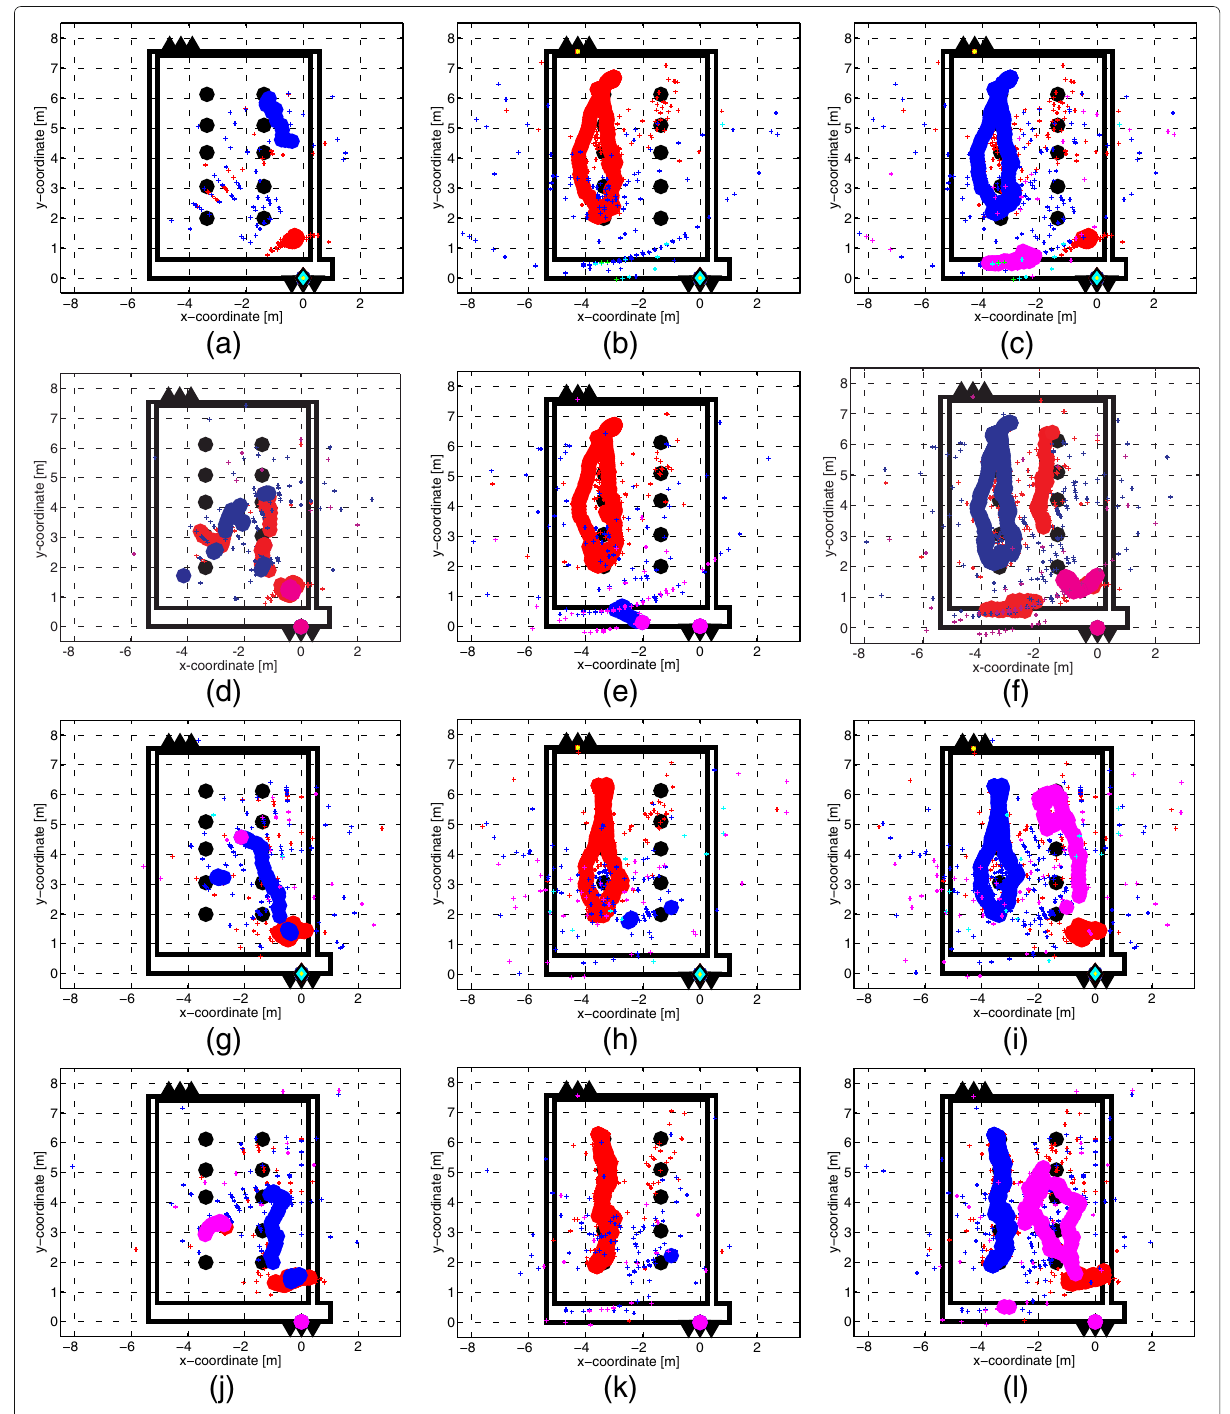
Fig. 12 Tracking results for scenario 2. Standard location of antennas and standard signal processing: a autonomously working sensor S1, b autonomously working sensor S2 and c two-node sensor network. Standard location of antennas and weak signal enhancement: d autonomously working sensor S1, e autonomously working sensor S2 and f two-node sensor network. Optimized location of the antennas & standard signal processing: g autonomously working sensor S1, h autonomously working sensor S2, i two-node sensor network. Optimized location of the antennas and weak signal enhancement: j autonomously working sensor S1, k autonomously working sensor S2 and l two-node sensor